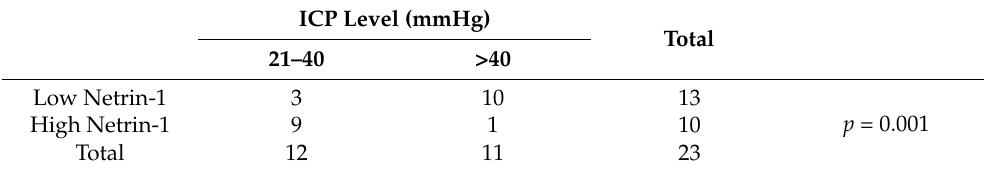
Figure 2. Serum Netrin-1 level indicated postoperative intracranial pressure and sensitivity to dehy- dration therapy. ( a ) The relationship between serum Netrin-1 concentrations and ICP peak among patients. ( b ) The relationship between serum Netrin-1 concentrations and average mannitol con- sumption during hospitalization. ( c ) Differences in terms of serum Netrin-1 concentrations between moderately high ICP group (ICP 21–40 mmHg) and severe high ICP group (ICP > 40 mmHg). ( d ) Dif- ferences in ICP peak between the high Netrin-1 group and the low Netrin-1 group. ( e ) Differences in average mannitol consumption between the high Netrin-1 group and the low Netrin-1 group. Table 3. Comparison of ICP level between the high Netrin-1 group and the low Netrin-1 group.